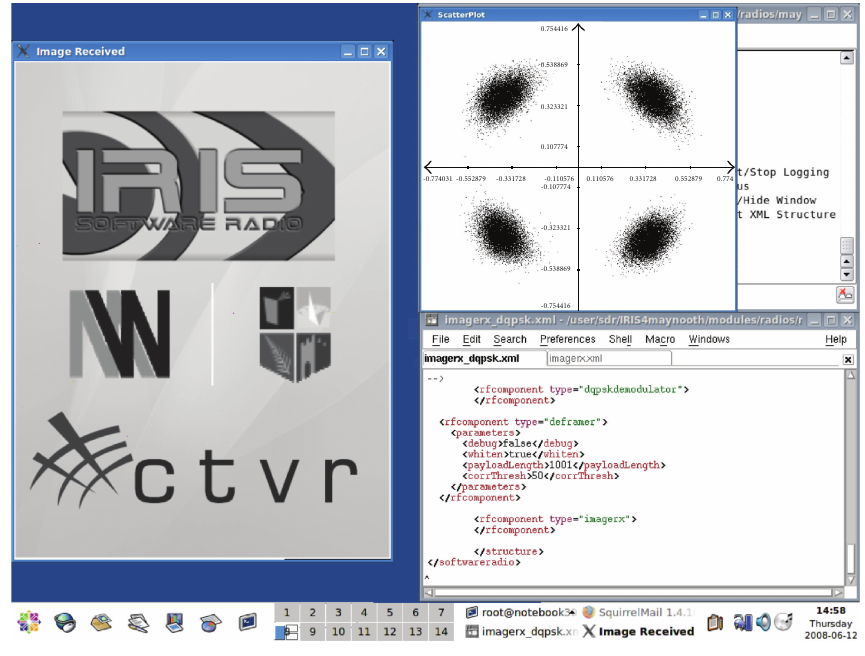
Figure 9: Transmitted image with constellation diagram.